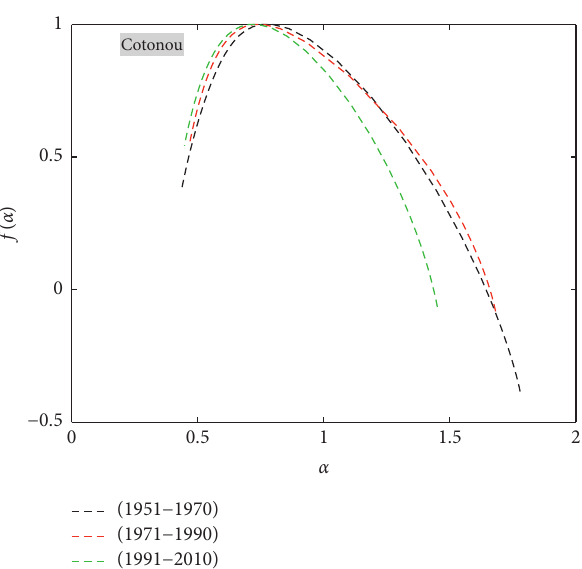
Figure 7: Multifractal spectra of precipitation recorded at Cotonou synoptic station, plotted for 1951–1970 (black color), 1971–1990 (red color), and 1991–2010 (green